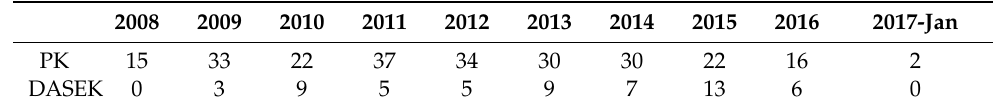
Table 1. The frequency of penetrating keratoplasty (PK) and Descemet stripping automated endothelial keratoplasty (DSAEK) for every year from 2007 to 2017.